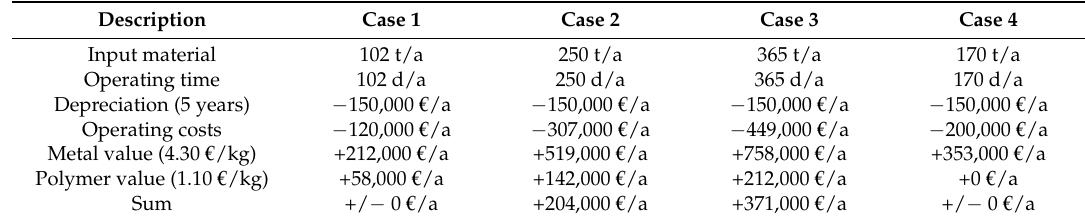
Table 3. Possible business cases for the implementation of the developed recycling process in production